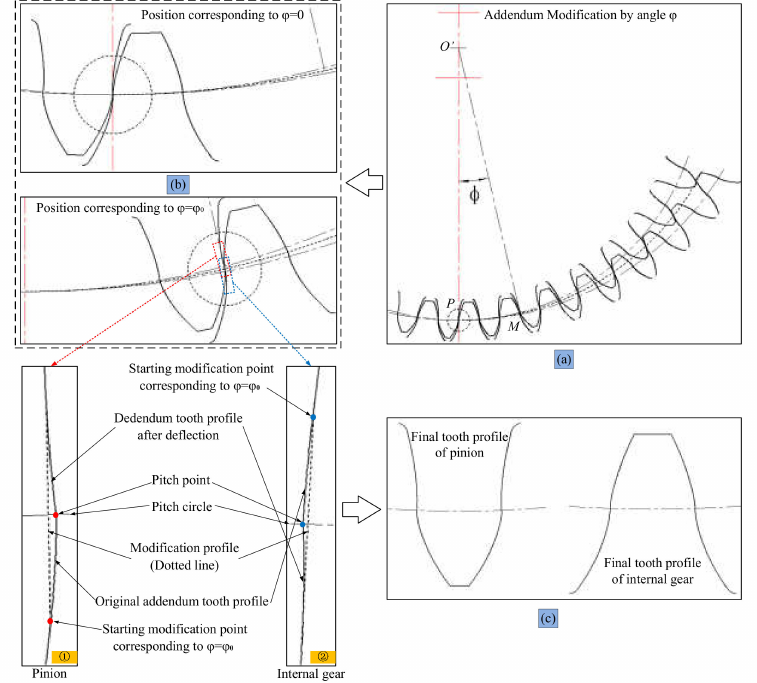
Figure 8. HCR gear tooth top-modification process. ( a ) Defined addendum modification parameters. ( b ) Cusp transition treatment at the connection between tooth top and tooth root profile modification: 1 (cid:13) Cusp modification of pinion. 2 (cid:13) Internal gear tip modification. ( c ) The tooth profile after tooth crest and root modification of pinion and internal gear with smooth cusp